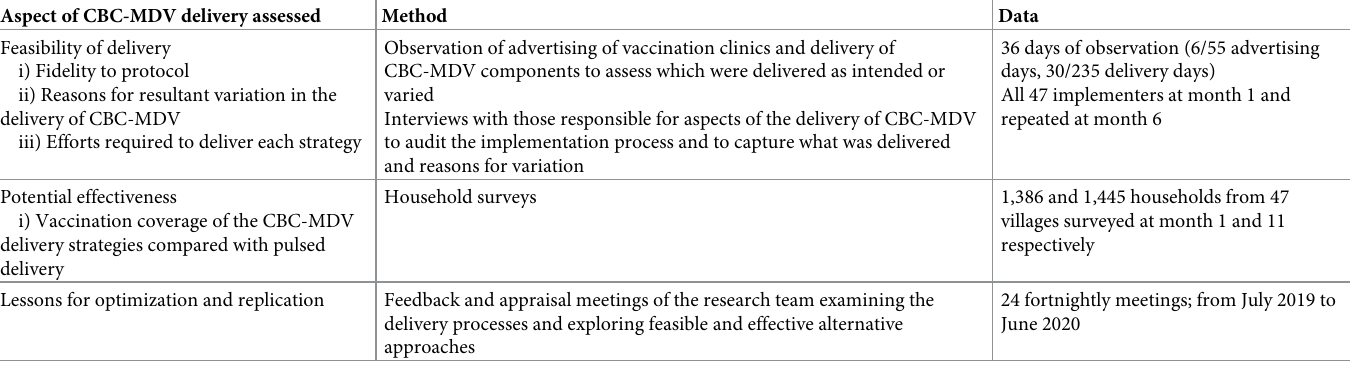
Table 2. Summary of research methods used to assess the feasibility of delivering community based continuous mass dog vaccination (CBC-MDV), potential effec- tiveness and formulate lessons learnt. Aspect of CBC-MDV delivery